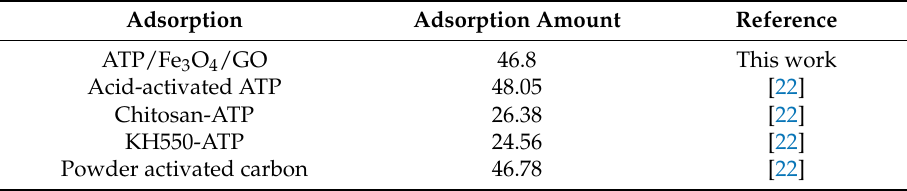
Table 4. The adsorption capacity for PRO onto different